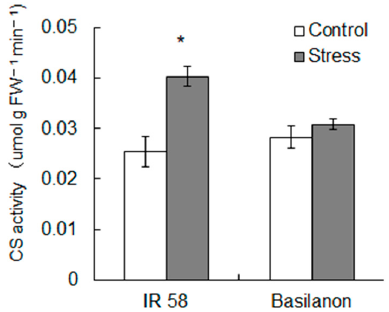
Figure 5. Effect of Osmotic stress on the citrate synthase (CS) activity in roots. Roots were sampled 7 days (168 h) after treatment for the determination of CS activity. Bars indicate the standard error (n = 5). An asterisk represents a significant difference between treatments ( t -test, p < 0.05).